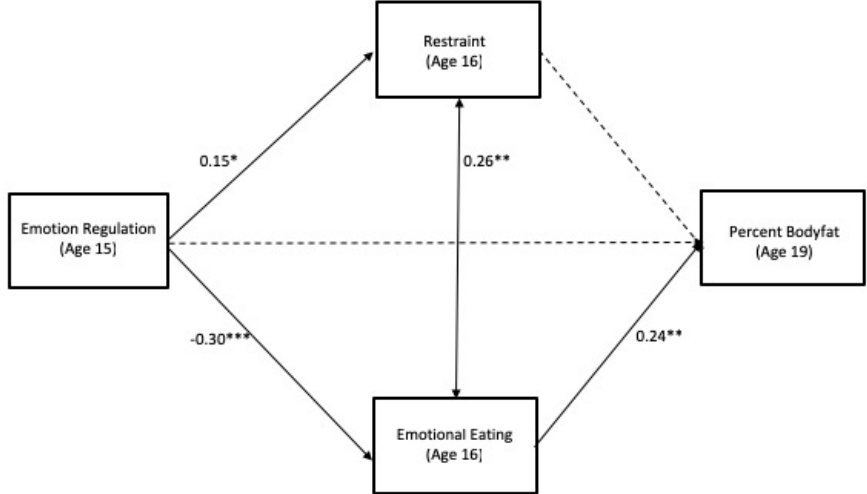
Figure 1. Standardized Estimates and Model Fit. Model Fit: χ 2 (14, N = 167) = 96.84, p = 0.00, CFI = 0.95, RMSEA =0.05 [CI = 0.01, 0.15]. Note: Sex, SES were covariates; Non-significant paths are shown as dashed lines and significant paths are shown as solid lines. * = p < 0.05; ** = p < 0.01; *** = p < 0.001.